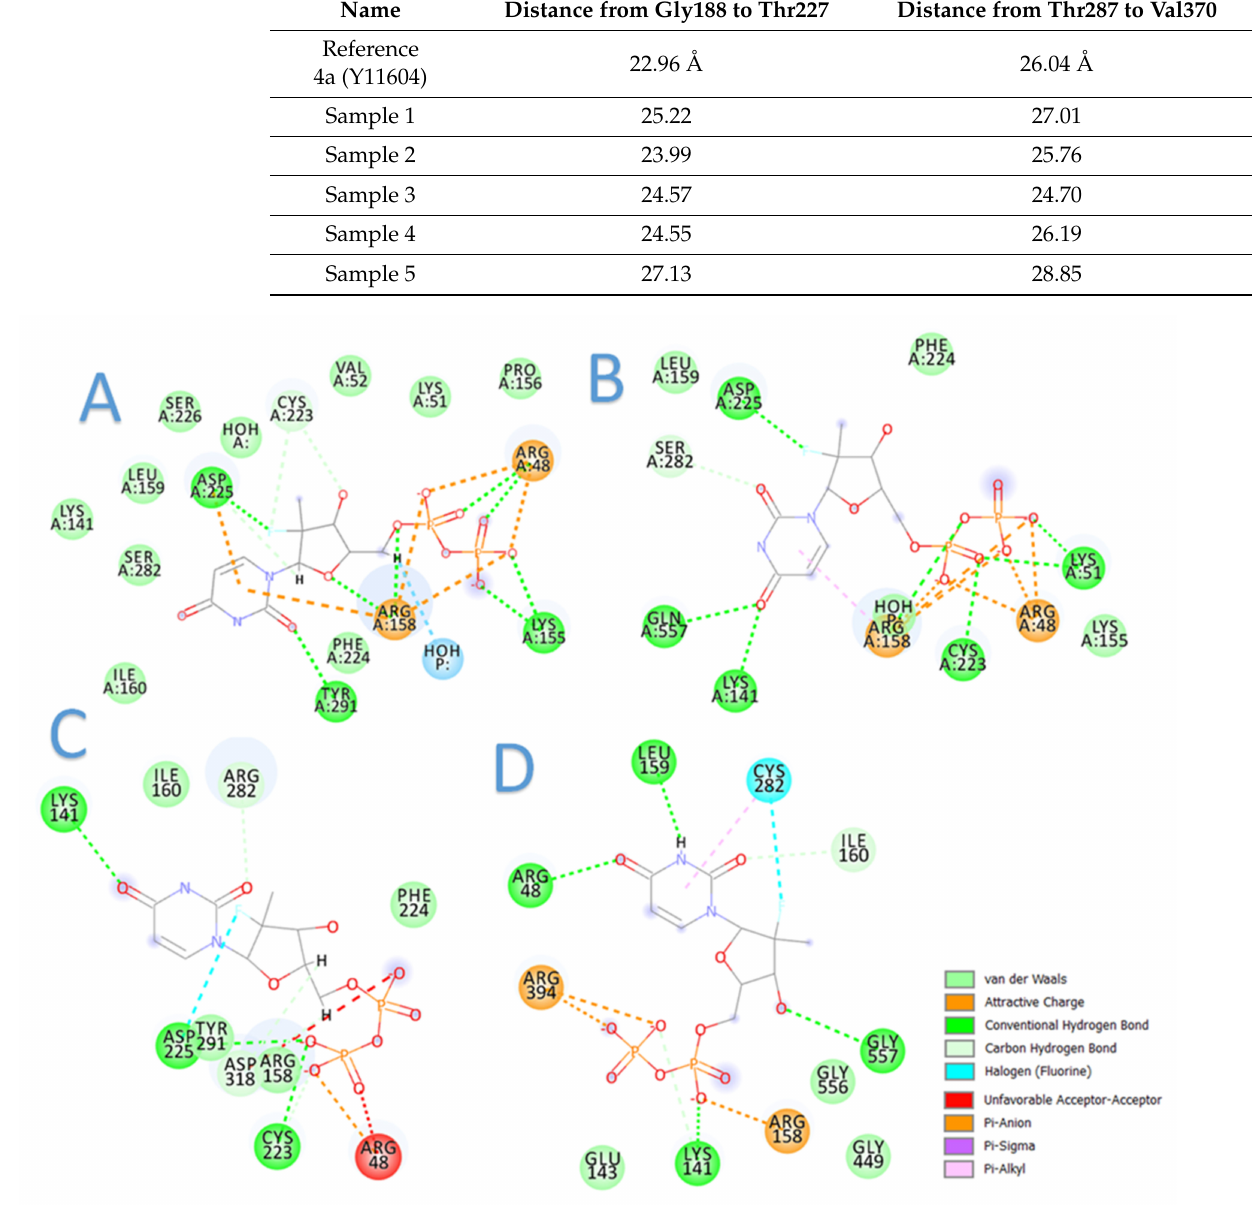
Figure 6. Two-dimensional diagrams of sofosbuvir interaction with HCV GT4a NS5B: ( A ) sample 9 (responder), ( B ) sample 10 (responder), ( C ) sample 3 (resistant), and ( D ) sample 5